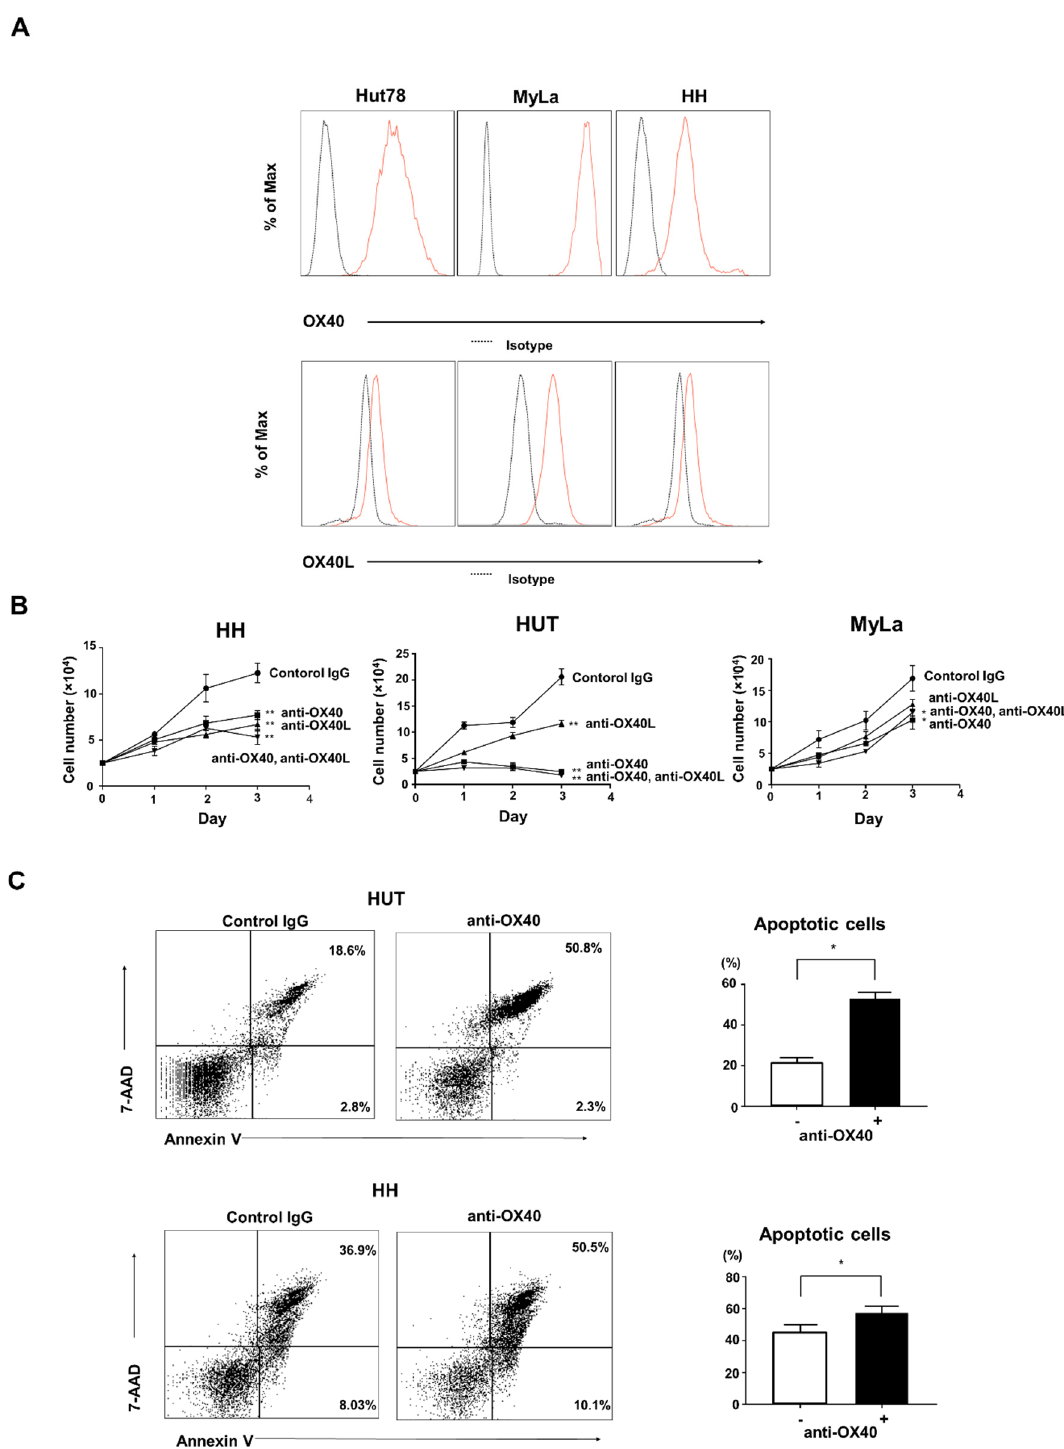
Figure 4. Involvement of OX40 and OX40L in CTCL cell lines. ( A ) OX40 and OX40L expression was analyzed by flow cytometry in human CTCL cell lines (Hut78, MyLa, and HH cells). ( B ) HH, Hut, and MyLa cells (1.0 × 10 5 /well) were cultured with anti-OX40 (5 µg/mL) and/or anti-OX40L (5 µg/mL) neutralizing antibodies for 48 hours. ( C ) Hut and HH cells (1.0 × 10 5 /well) were cultured with anti-OX40 neutralizing antibody (5 µg/mL) for 24 hours. Apoptosis (Annexin V + and 7-AAD − ) was evaluated with Annexin V and 7-AAD staining for flow cytometric analysis. * p < 0.05, ** p < 0.01.